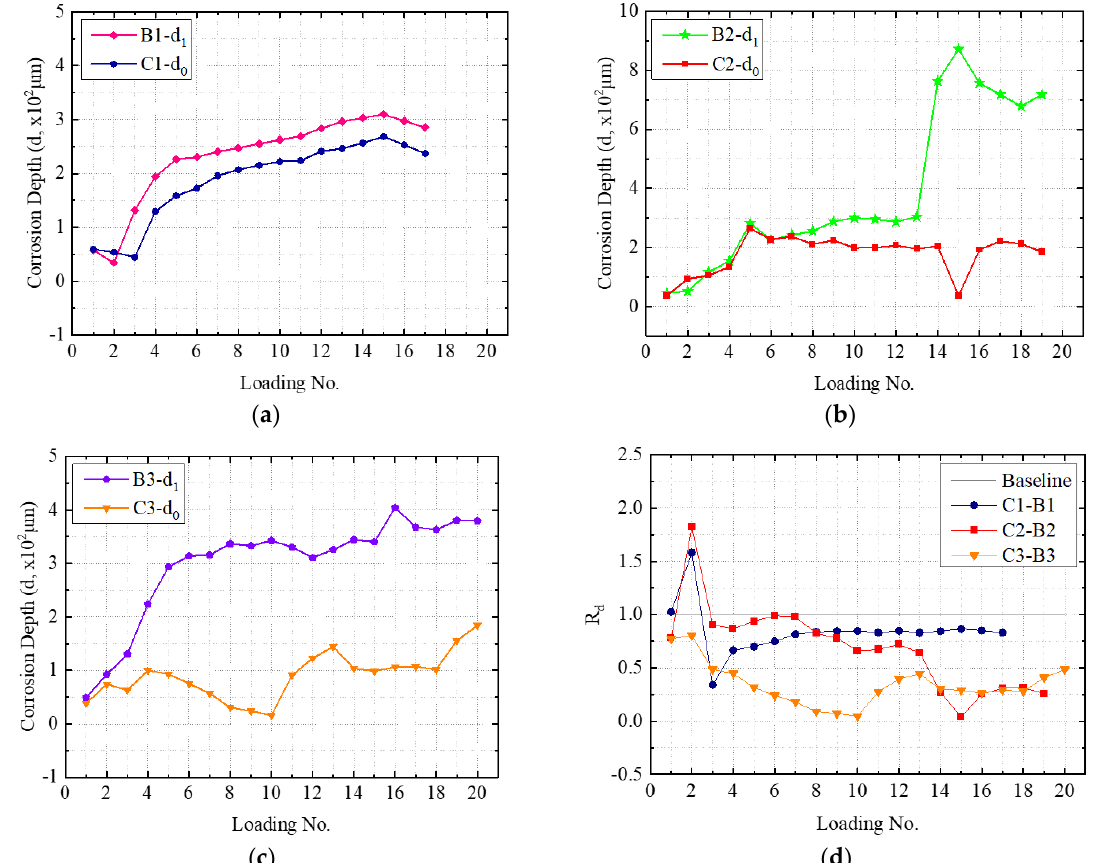
Figure 16. Comparison corrosion depth severity ratio: ( a ) Sample B1-C1, ( b ) Sample B2-C2, ( c ) Sample B3-C3, and ( d ) Corrosion depth severity with impact from external temporary loads.